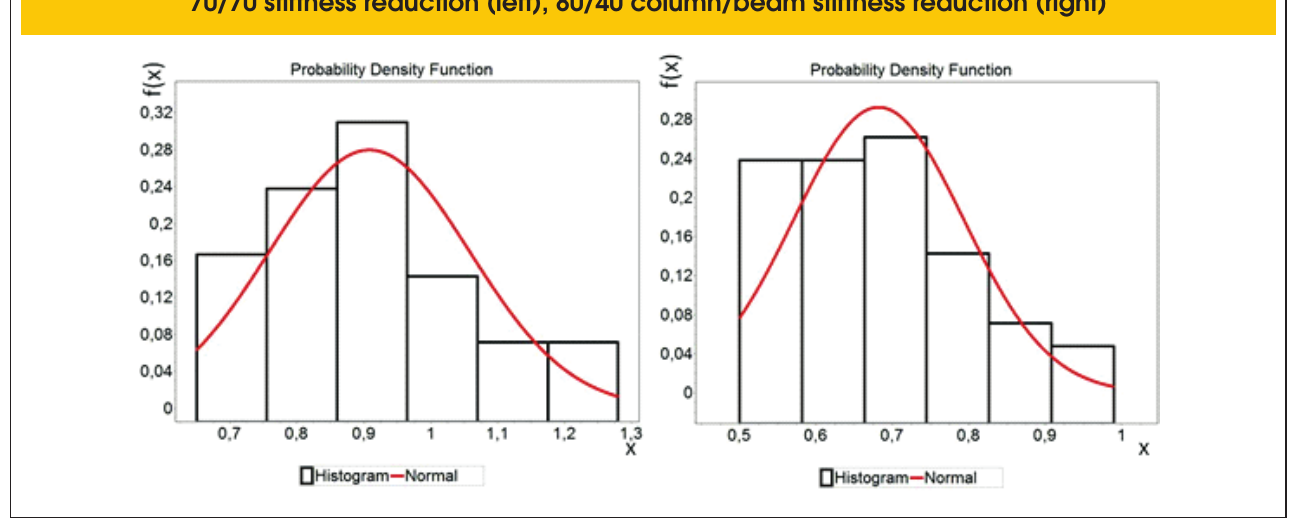
Figure 4 – Histograms and probability distribution functions of model error